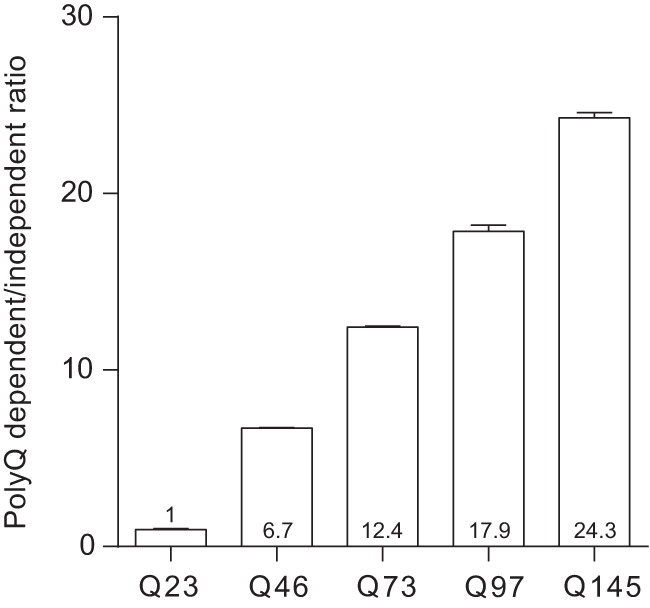
PolyQ-dependent signal increases with longer glutamine stretches. HEK cells were transiently transfected with full-length HTT expressing different polyQ lengths. The ratio between polyQ-dependent and -independent assay signal was calculated as average of the ratio in three different experiments where the average values are indicated in each bar for ease of reading. Data are presented as mean ± SEM.